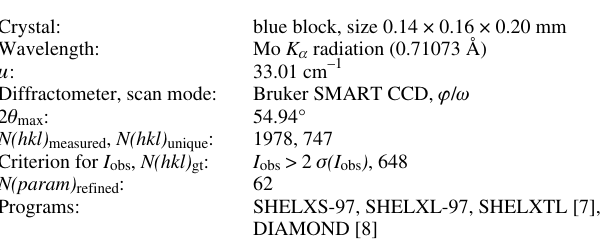
Table 1. Data collection and handling.